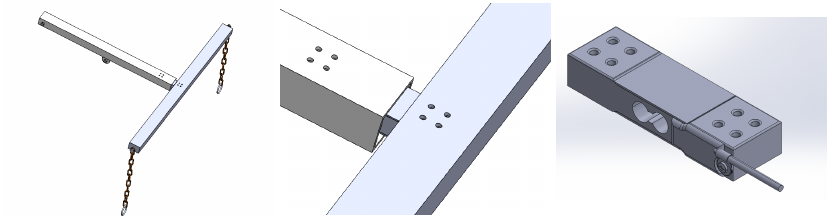
Figure 5. Upper support bars with the load cell. Dimensions for upper support bar and front support bar are illustrated in Figure 6.